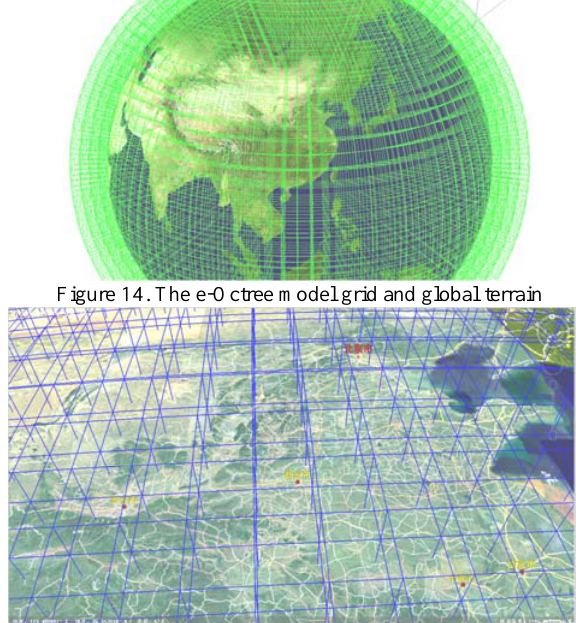
Figure 18. The e-Octree model grid and satellite’s position 1